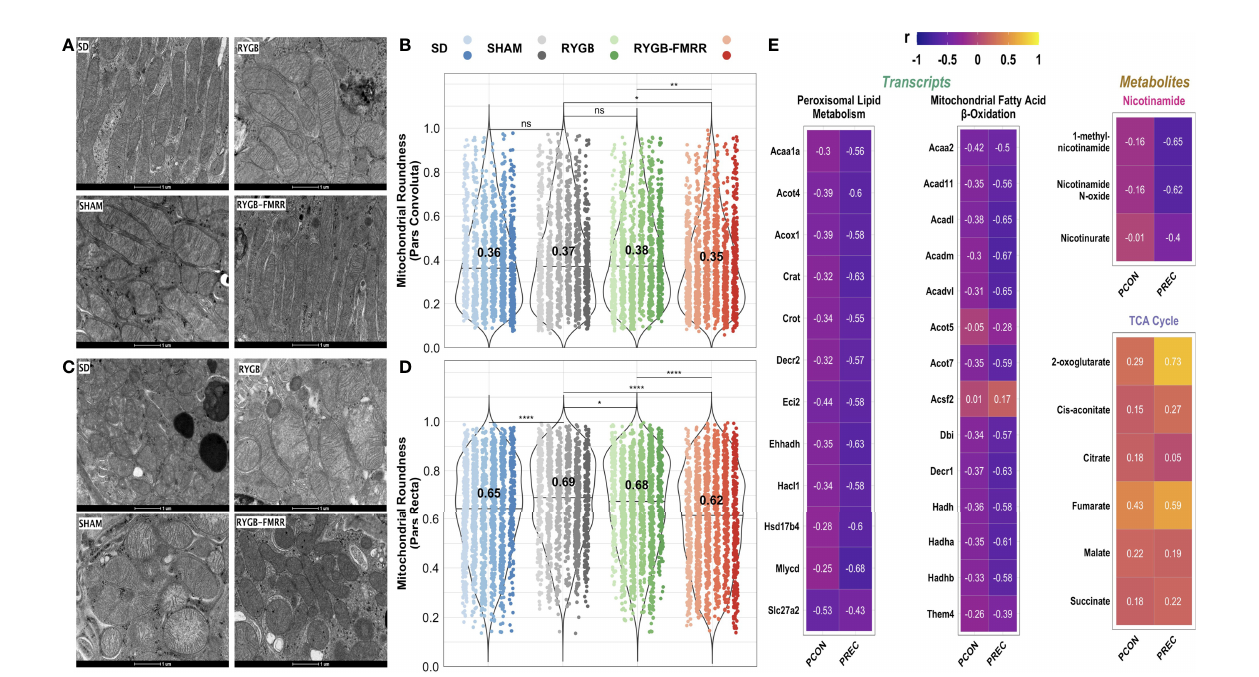
FIGURE 10 | Changes in proximal tubular mitochondrial roundness and their relationship to renal cortical FAO transcripts and urinary nicotinamide and TCA cycle metabolites. (A, C) Representative images (16500x, scale bar 1µm) of transmission electron microscopy images of mitochondria in the pars convoluta (A) and pars recta (C) regions of the proximal tubule from the four experimental groups. (B, D) Mitochondrial roundness in the pars convoluta (B) and pars recta (D) was quanti fi ed using transmission electron microscopy images from 6 animals per group. Mitochondria were quanti fi ed in 15 non-overlapping images captured from 3 distinct pars convoluta and pars recta regions (5 images/region) for each animal. Data are plotted as violin plots with individual mitochondrial measurements superimposed. Within each group, each animal is identi fi ed as its own column of dots with a unique colour shade. Median group values are identi fi ed by the horizontal black line in each violin and printed on each violin. Statistical signi fi cance of between-group differences derived from multiplicity-corrected Wilcoxon rank-sum tests is presented. Statistical signi fi cance is denoted as follows: ns = not signi fi cant; * = p <0.05; ** = p <0.01; *** = p <0.001; **** = p <0.0001. (E) Correlation plots highlighting Pearson correlation r values for mitochondrial roundness (pars convoluta and pars recta) correlations with renal cortical transcripts and urinary metabolites. Regularized log-transformed gene expression counts were used for gene-structure correlations. Transcripts plotted are those which resulted in enrichment of peroxisomal and mitochondrial lipid metabolism pathways in RYGB-FMRR rats (also highlighted in the circular network plot in Figure 2D ). PQN-normalized urinary 1 H-NMR peaks from samples obtained at 4 weeks after intervention were used for metabolite-structure correlations. Metabolites involved in nicotinamide metabolism (PPAR a biomarkers) and TCA cycle intermediates, many of which were differentially abundant between RYGB-FMRR and RYGB rats, are plotted. Individual cells in the correlation plots are scaled by colour indicating strength and directionality of the correlation. PCON, pars convoluta; PPAR a , peroxisome proliferator-activated receptor- alpha; PREC, pars recta; RYGB, Roux-en-Y gastric bypass; RYGB-FMRR, Roux-en-Y gastric bypass plus feno fi brate, metformin, ramipril, and rosuvastatin; SD, Sprague Dawley; SHAM, sham surgery (laparotomy); TCA, tricarboxylic